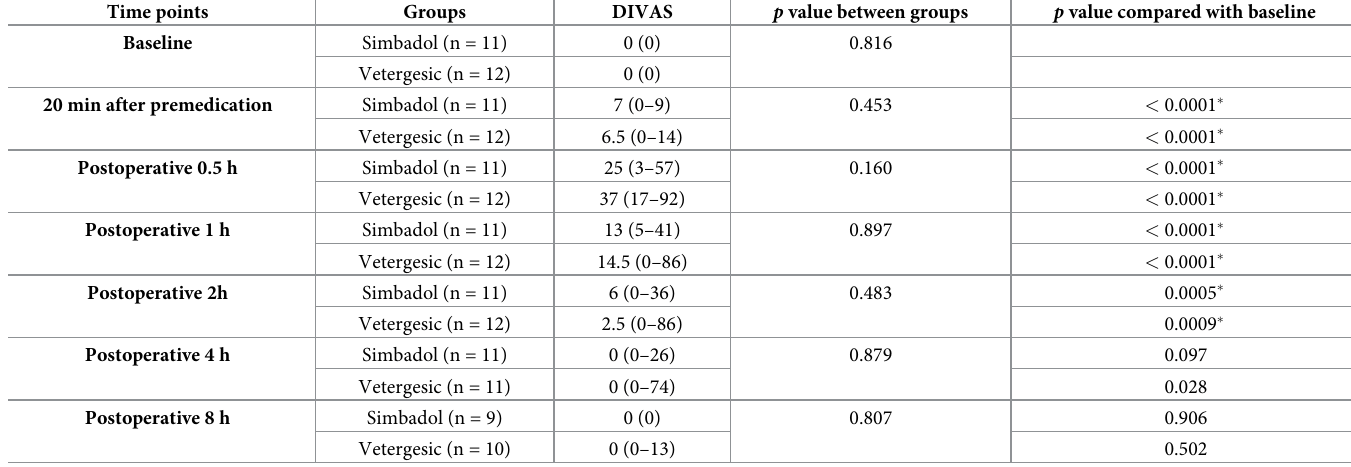
Table 4. Dynamic and interactive visual analog scale (DIVAS) scores in cats undergoing dental extractions after the administration of Simbadol or Vetergesic. Val- ues are expressed as median